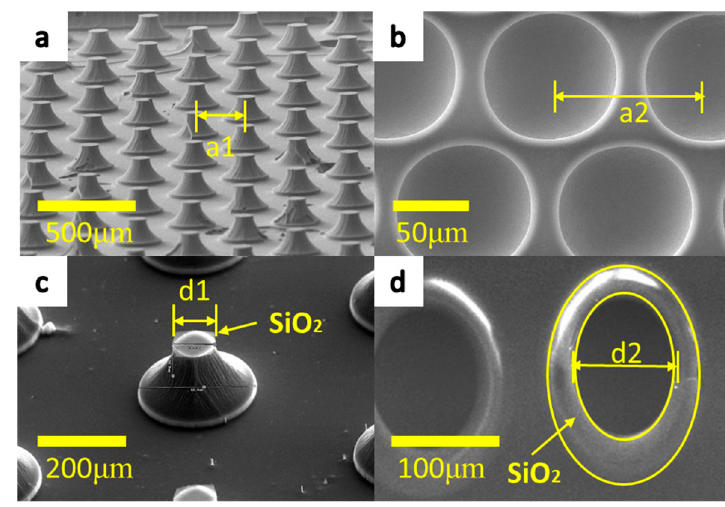
Figure 3. The schematic diagram of parameters d 1 , a 1 , d 2 , and a 2 in the SEM view. ( a ) a 1 , the distance between the two center point of tips masks is 240 μ m, that is, the No. 5 tip sample, ( b ) a 2 , the distance between the two center point of pits masks is 100 μ m, that is, the No. 1 pit sample, ( c ) d 1 , the distance between the two center point of tips masks, is 33.6 μ m, that is, the No. 2 tip sample, ( d ) d 2 , the distance between the two center point of pits masks is 100 μ m, that is, the No. 2 pit sample.